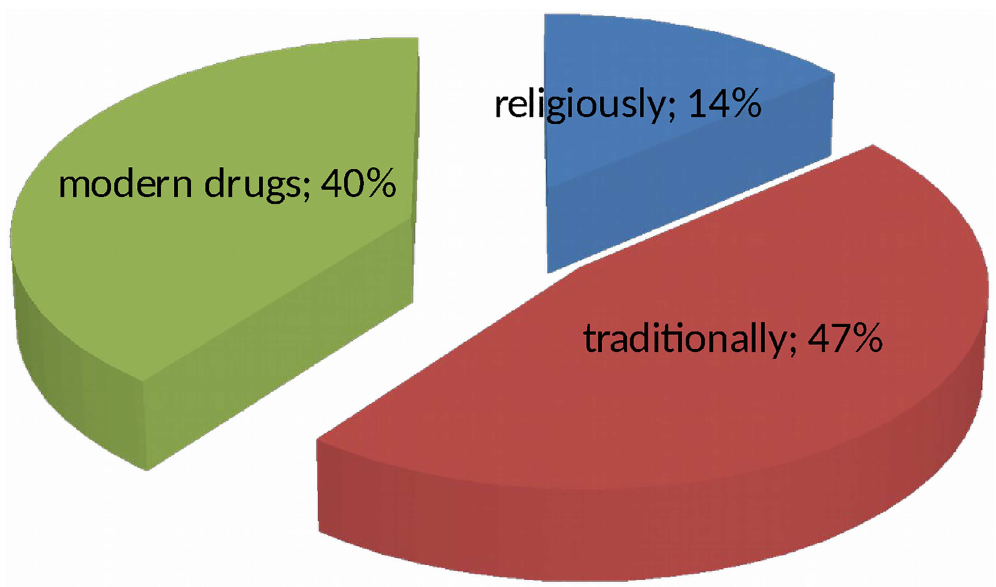
Fig 1. Perception of the patients about how the disease will be cured at Yirgalem General Hospital.